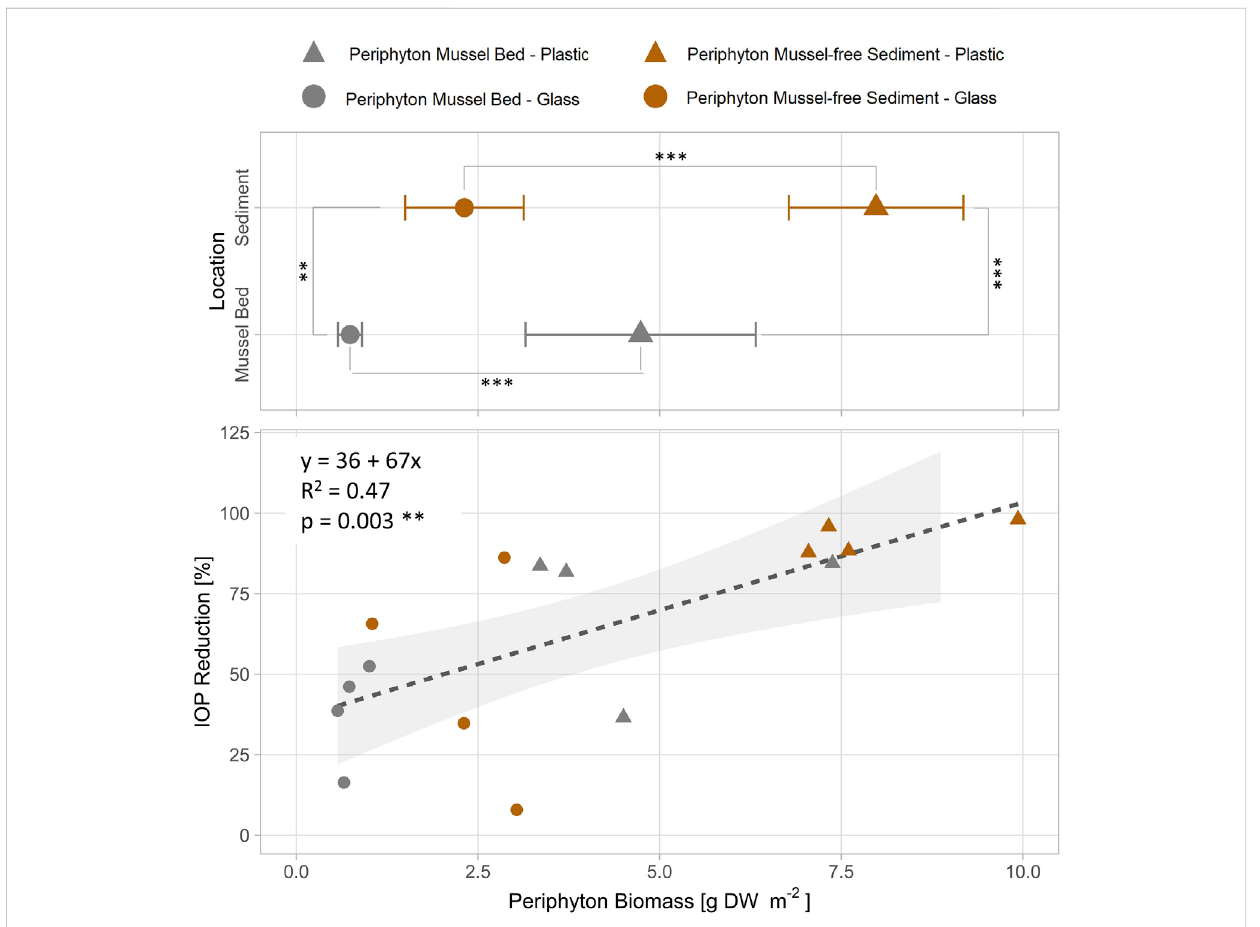
FIGURE 3 Linear relationship between biomass of periphyton (DW = dry weight) grown on different arti fi cial substrates (glass, plastic) at different locations without and with quagga mussels in Lake Müggelsee and removal of iopromide (IOP) after 30 days of exposure in batch cultures of Experiment 1 (periphyton only). Statistic differences between locations and materials tested with Welsh ’ s two-sided t -test. Stars indicate signi fi cant differences (*: p < 0.05; **: p < 0.01; ***: p <